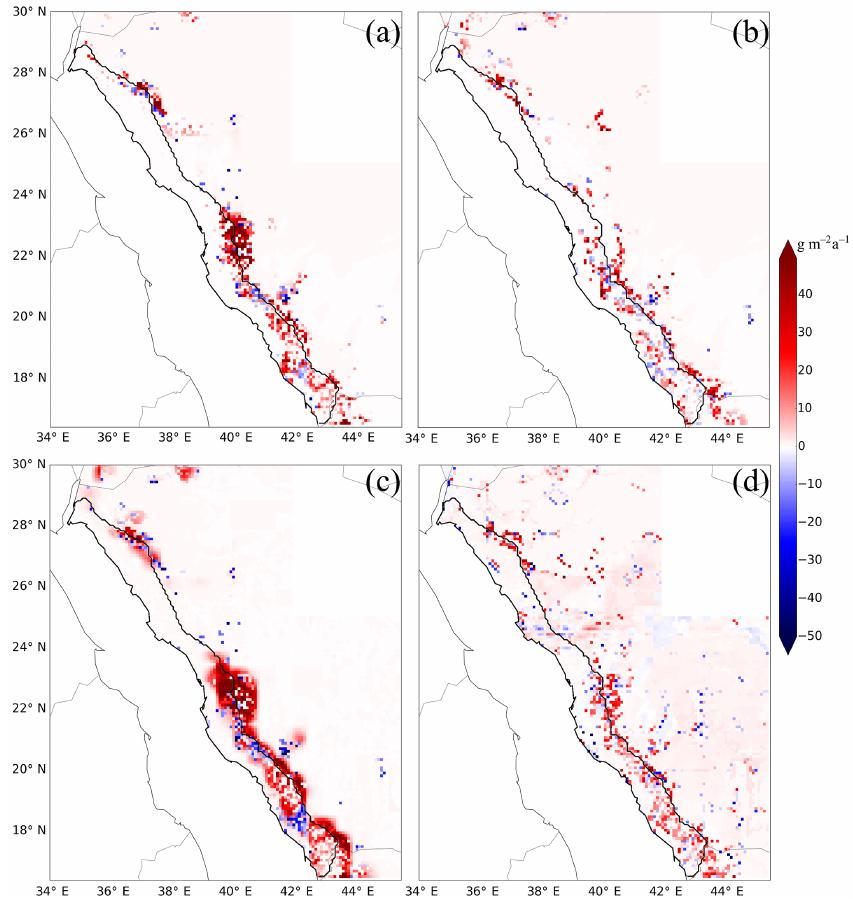
Figure 2. Differences between annual mean dust emission in model simulations (gm − 2 a − 1 ): (a) 10kmALL–10kmLLAI, (b) 10kmALL–